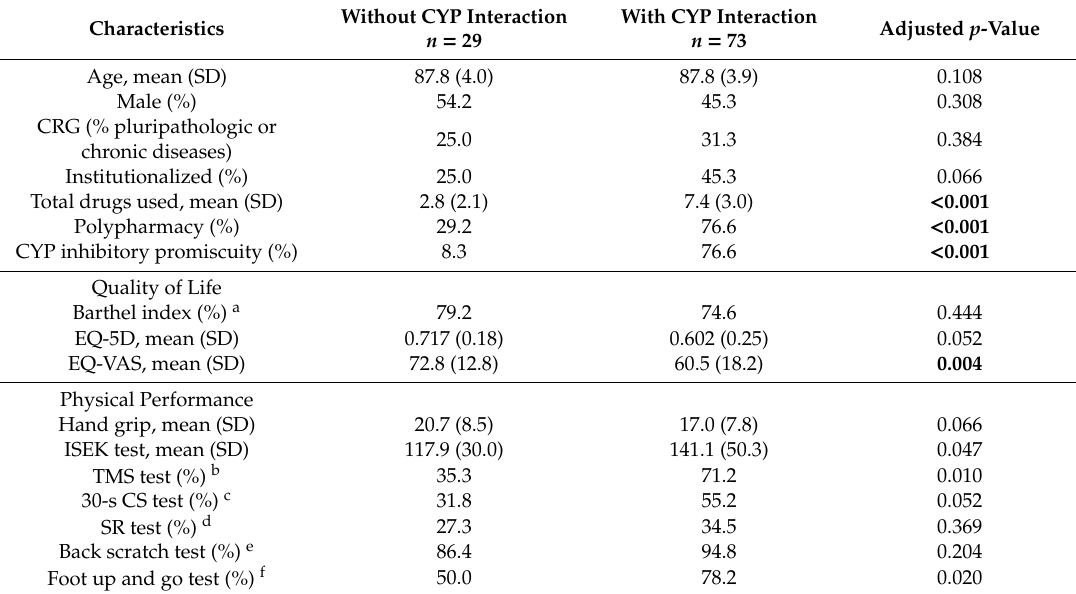
Table 2. Characteristics of the study